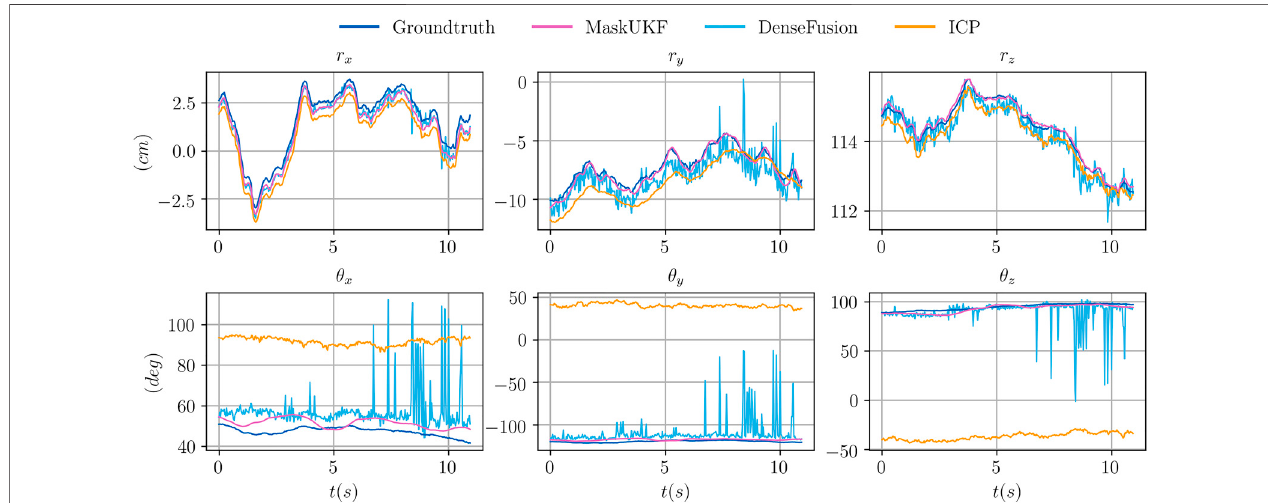
FIGURE 2 | Comparison of the trajectories of several algorithms for the object 021_bleach_cleanser within a subset of the sequence 0055 from the YCB Video Dataset. Our method is more precise than ICP and smoother than DenseFusion which exibits spikes and irregularities. In this fi gure, the orientation of the object is represented in a compact way using the Euler vector θ (cid:2) θ e obtained as the product of the axis of rotation e and the angle of rotation θ .